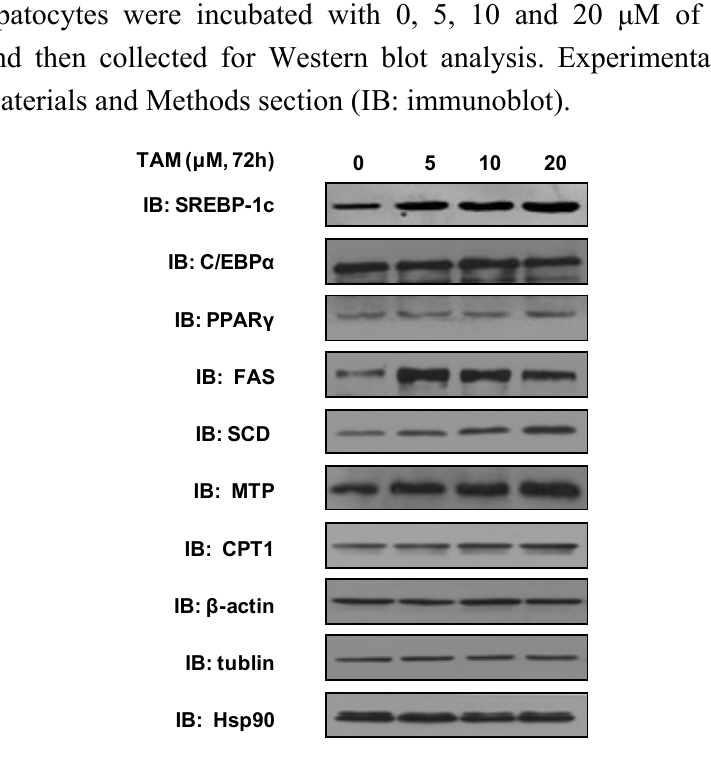
Figure 5. The effect of increasing concentrations of TAM on the cell proliferation of HepG2. Hepatocytes were incubated with 0, 5, 10 and 20 μM of TAM for 72 h, respectively, and then collected for cell viability assay. Experimental procedures are shown in the Materials and Methods section. Data are expressed as the means ± SD ( n = 6). No statistically significant difference in cell proliferation was observed when cells were treated with 5–20 μM of